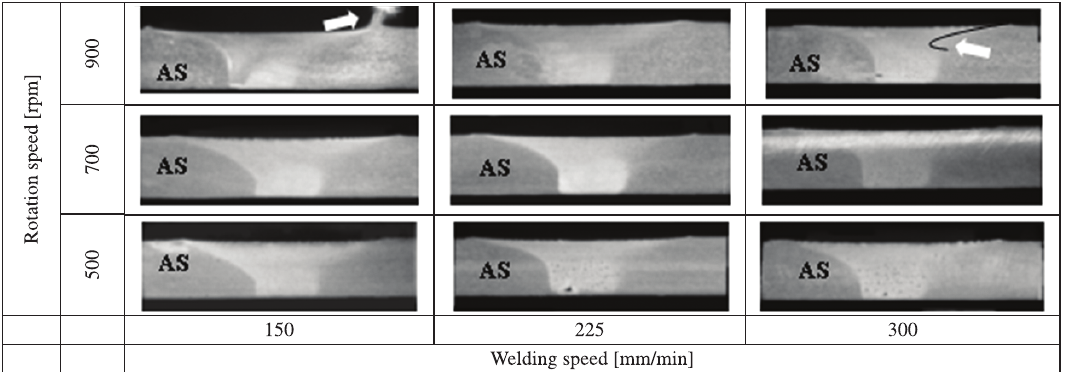
Figure 2. Cross-sections of representative joints welded at the different process parameters ( AS = advancing side). Table 2. Values of the RP [mm / rev] for each couple of adopted welding parameters.